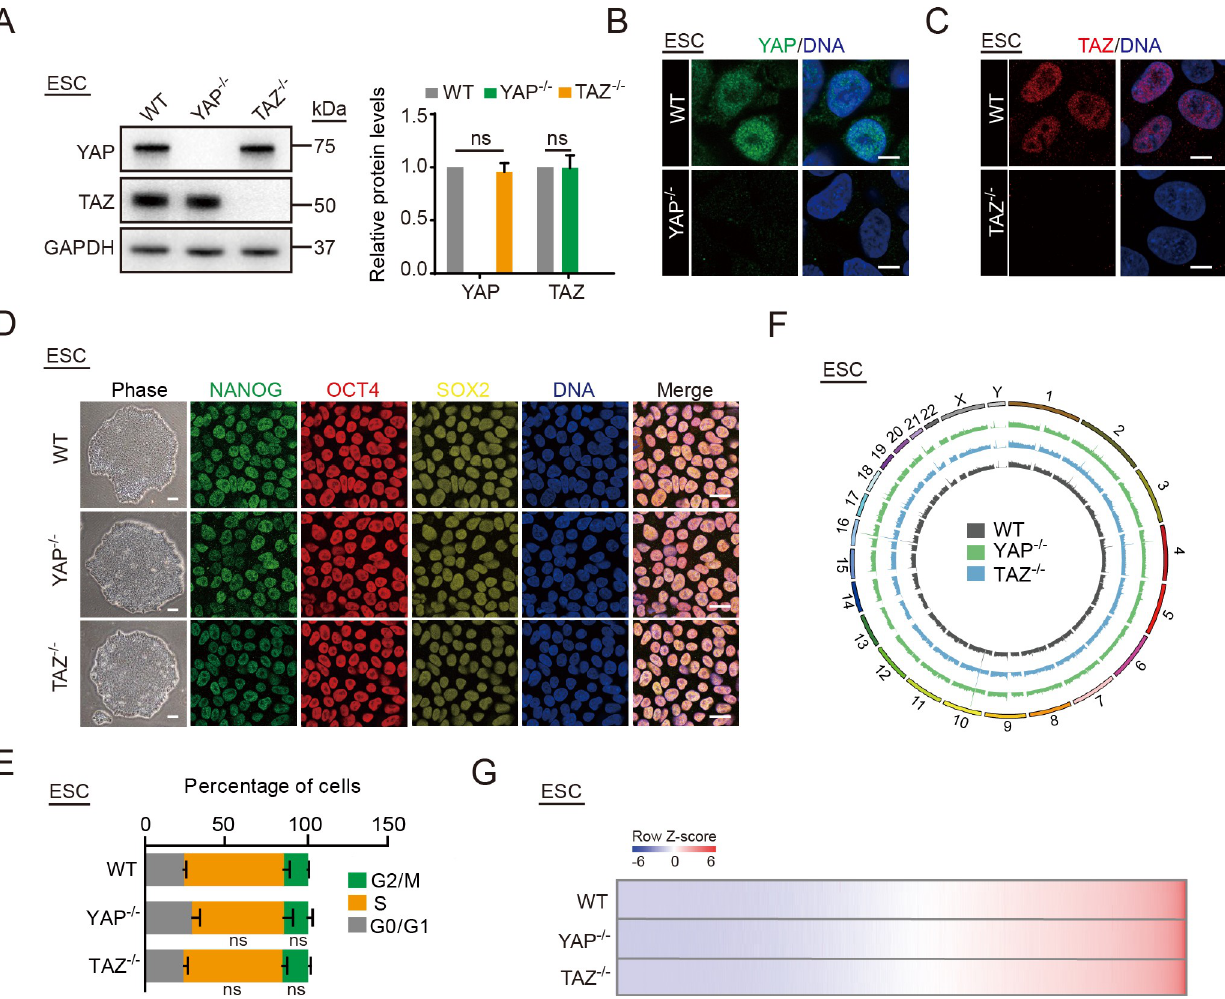
Fig 1. Generation of YAP − / − and TAZ − / − hESCs. (A) Western blot analysis of YAP and TAZ in YAP − / − and TAZ − / − hESCs. GAPDH was used as a loading control (left). The protein levels normalized with GAPDH were shown as fold change relative to WT hESCs (right). Data are presented as the mean ± SD, n = 3. (B) Immunostaining of YAP in WT and YAP − / − hESCs. Scale bar, 10 μ m. (C) Immunostaining of TAZ in WT and TAZ − / − hESCs. Scale bar, 10 μ m. (D) Immunofluorescence analysis of pluripotency markers NANOG, OCT4, and SOX2 in WT, YAP − / − , and TAZ − / − hESCs. Scale bar of brightfield images is 200 μ m; scale bar of immunofluorescence images is 25 μ m. (E) Cell cycle analysis of WT, YAP − / − , and TAZ − / − hESCs. Data are presented as mean ± SD, n = 3. (F) Whole-genome sequencing analysis of CNVs in WT, YAP − / − , and TAZ − / − hESCs. (G) Heat map displaying the global transcriptomes of WT, YAP − / − , and TAZ − / − hESCs. The numerical data underlying this figure are included in S8 Data. CNV, copy number variation; ESC, embryonic stem cell; G, gap; GAPDH, glyceraldehyde-3-phosphate dehydrogenase; hESC, human embryonic stem cell; M, mitosis; ns, not significant; OCT4, organic cation/ carnitine transporter 4; S, synthesis; SOX2, SRY-box 2; TAZ, transcriptional coactivator with PDZ-binding motif; WT, wild type; YAP, Yes-associated protein.